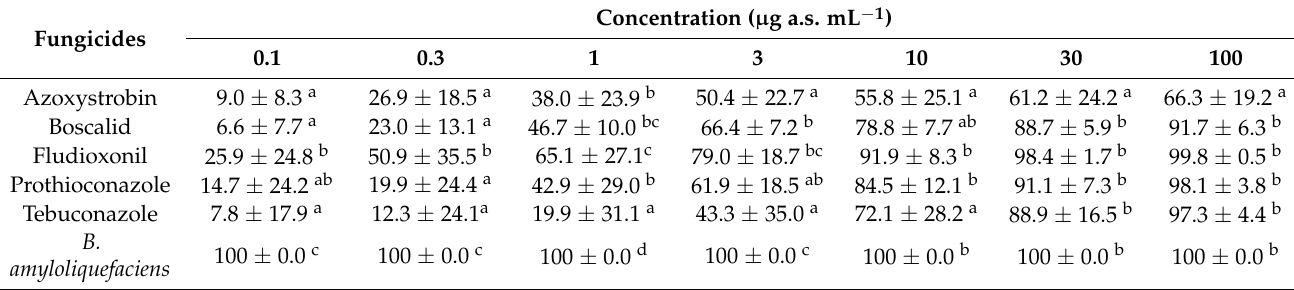
Table 4. Mycelial growth inhibition ± SD of Sclerotinia sclerotiorum isolates ( n = 68) grown on potato dextrose agar (PDA) amended with five fungicides as well as a biopesticide at seven concentrations a